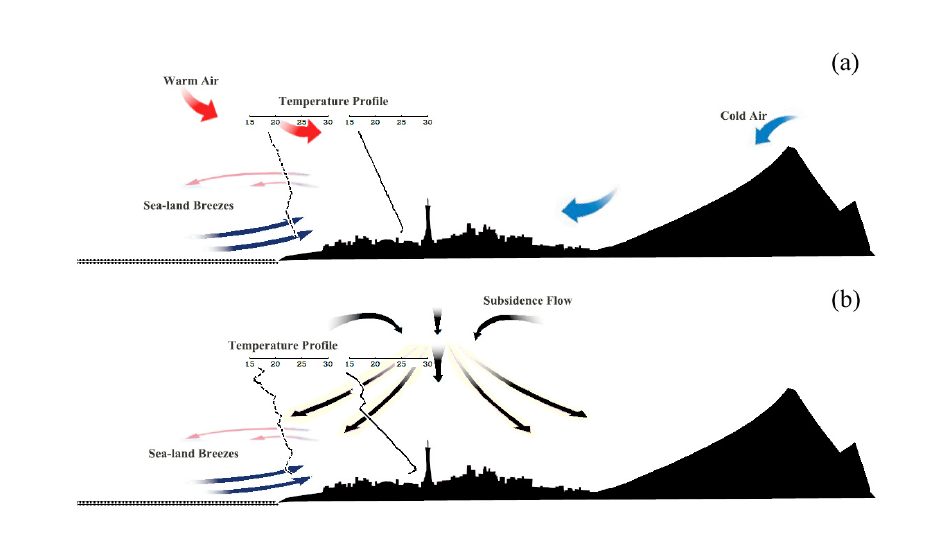
Fig. 11. Improved conceptual model of ABL influence on poor air quality over the PRD under different weather